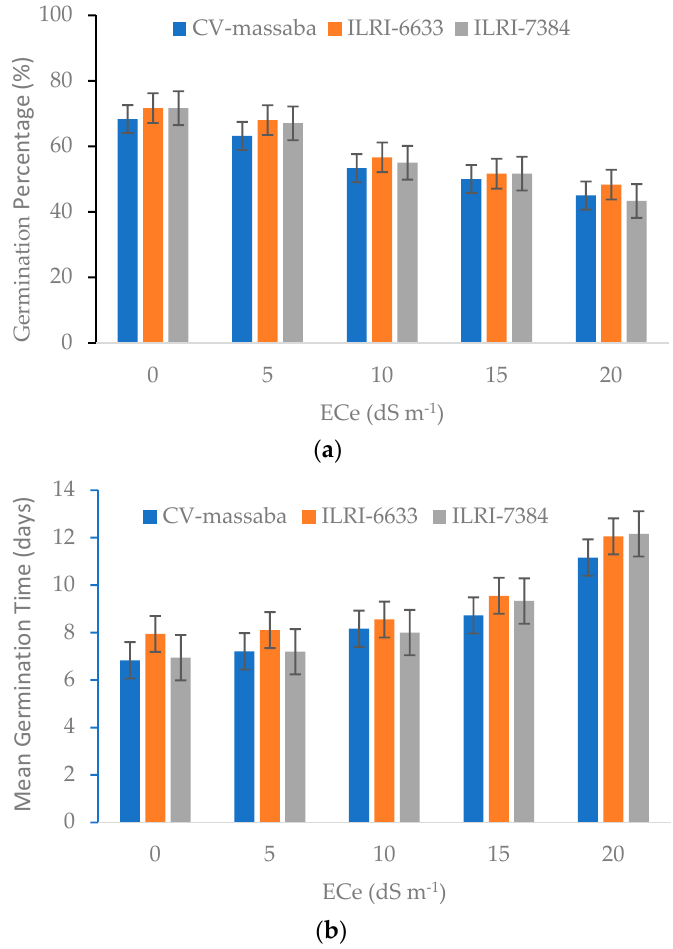
Figure 2. Effect of different salinity levels on ( a ) Germination Percentage (LSD = 6.69; CV = 12.32) and ( b ) Mean Germination Time (LSD = 0.86; CV = 9.68) of three selected Chloris gayana genotypes.